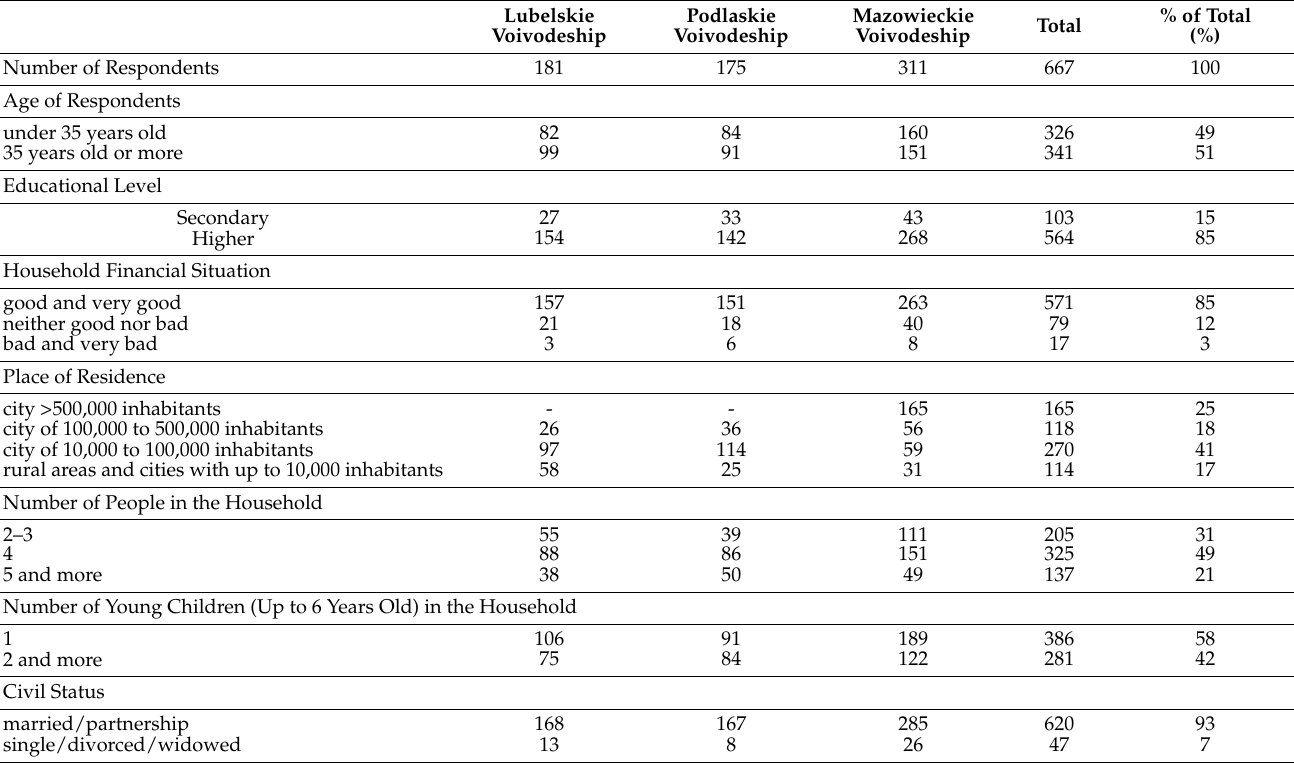
Table 3. Participant characteristics ( n = 667).